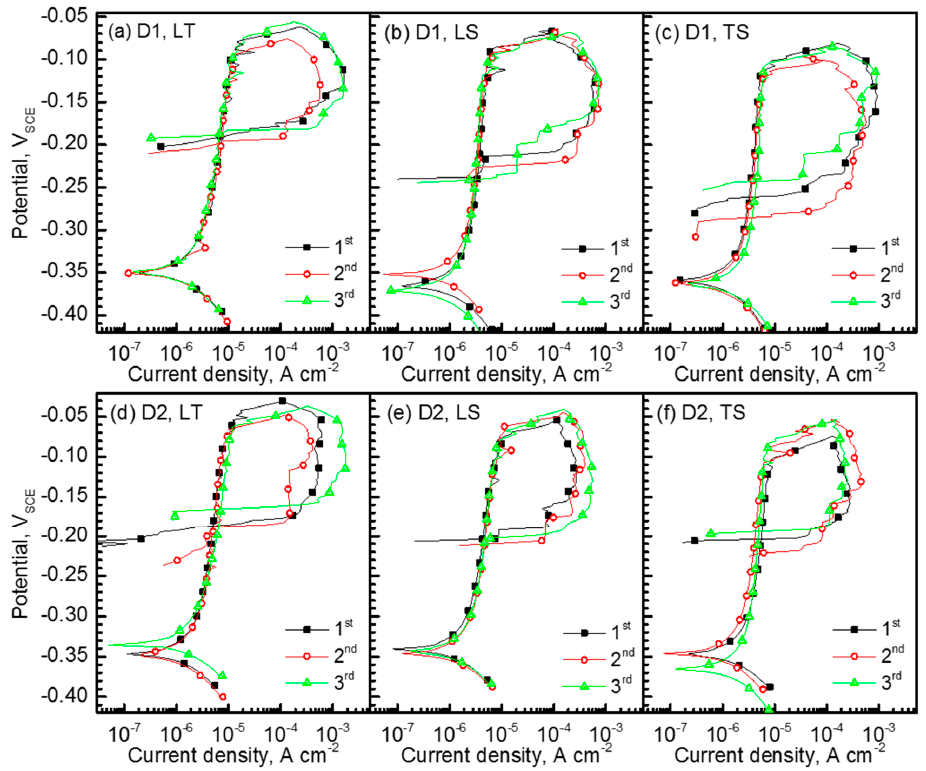
Figure 4. Cyclic polarization curves of ( a – c ) D1 and ( d – e ) D2 specimens measured in 2 M NaCl solution at 50 °C at a potential sweep rate of 1 mV·s − 1 . The polarization tests were conducted on ( a , d ) LT; ( b , e ) LS; and ( c , f ) TS planes.